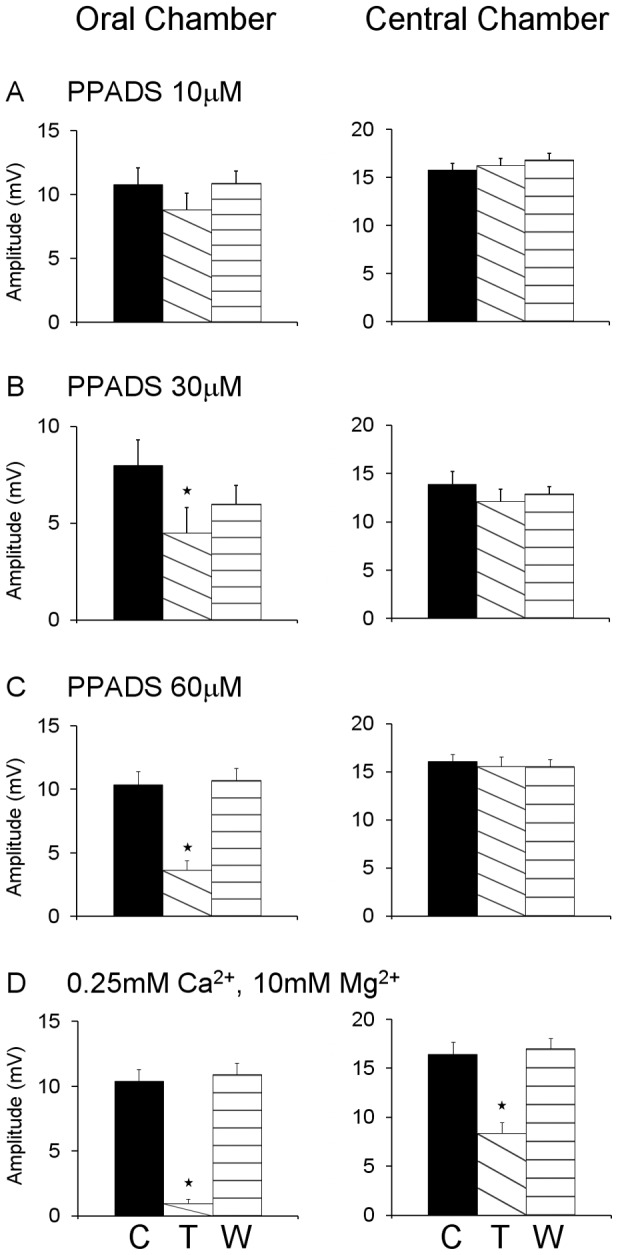
Concentration-effect relation for PPADS in the central chamber on descending inhibitory reflexes.The effects of 10 µM (top panels), 30 µM (second panels) and 60 µM (third panels) PPADS in the central chamber on IJPs evoked in the anal chamber by distension in the far (oral) chamber (left column) and central chambers (n≥6 in each case). These are compared with the effects of complete synaptic blockade by a 0.25 mM Ca2+, 10 mM Mg2+ solution in the central chamber on the same responses (n = 6). Synaptic blockade significantly depressed reflexes whether they were evoked in the far or the central chamber, although it was much more effective on reflexes conducted through this chamber than those evoked in it. The effect of PPADS on reflexes conducted through the central chamber from far chamber distension was concentration-dependent with 10 µM having no effect, but even 60 µM PPADS was less effective than complete synaptic blockade. C indicates data obtained in control physiological saline, D indicates data obtained with either PPADS or the low Ca2+, high Mg2+ solution in the central chamber, W indicates data obtained at least 20 minutes after the solution in the central chamber was returned to control.